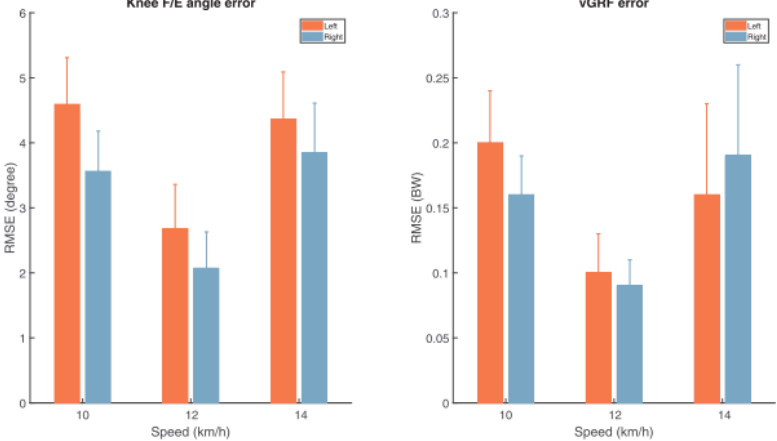
Figure 22. Accuracy of the estimated GRF and knee flexion/extension for different running speeds using single-subject training [89].